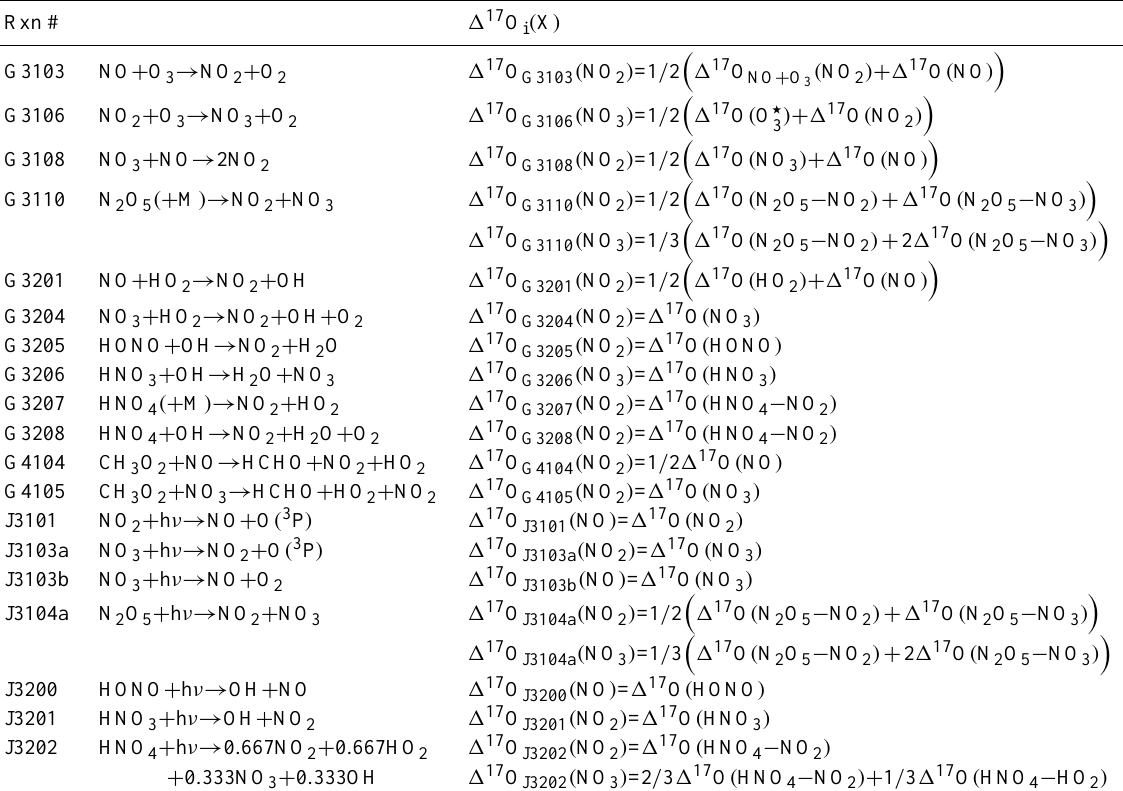
Table 2. 1 17 O i ( X ) for Case 2 ( explicit NO x ). Only equations featuring different 1 17 O i ( X ) than in Case 1 (PSS NO x ) are presented